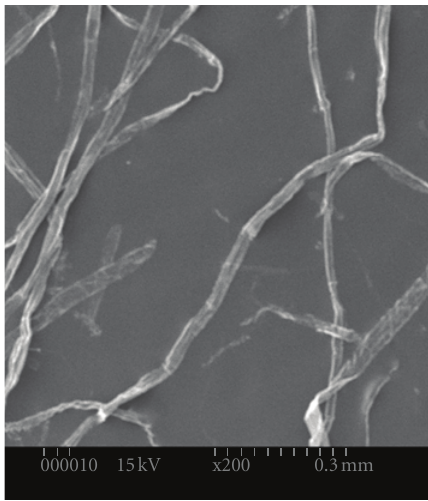
Figure 1: Scanning electron micrograph (SEM) of wood fibre.